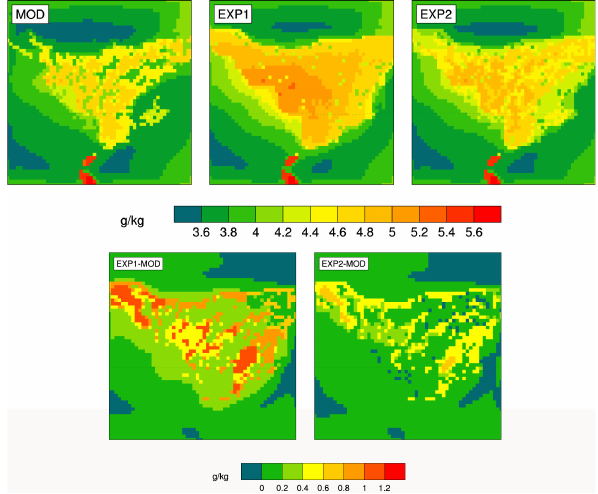
Fig. 9. Specific humidity at 2m above ground and its differences be- tween the MOD and the EXP1 and EXP2 simulations at 13:00BT, 6 July 2004.